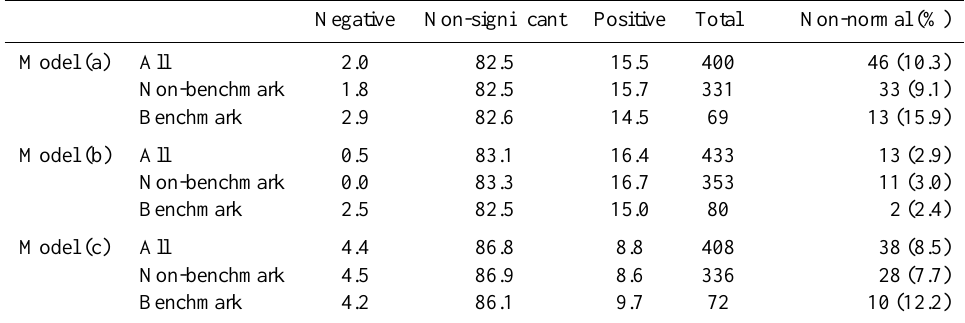
Table 2. Comparison of the proportions of significant and non-significant estimated slope coefficients in the whole data set, the non-natural series and near-natural series – winter maxima series.